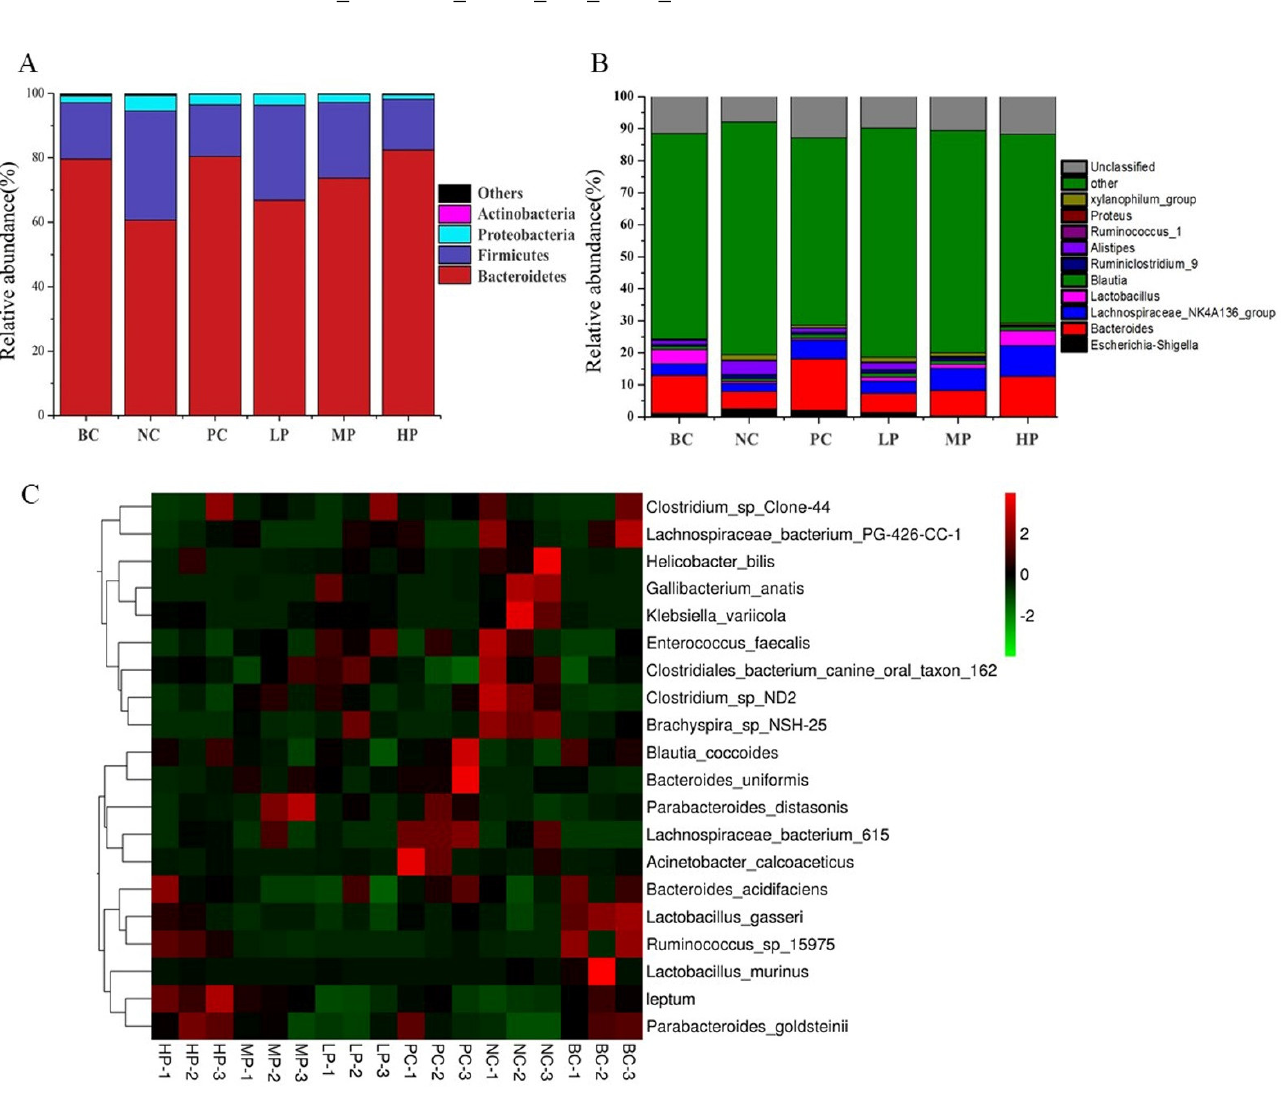
Figure 5. Composition of the gut microbiota represented by the stacking histograms at phylum level ( A ) and genus level ( B ), as well as a heatmap at species level ( C ). BC (blank control) represents healthy mice; NC (negative control) represents AAD mice without treatment; PC (positive control) represents AAD mice administrated with 200 mg/kg BW of inulin; LP, MP and HP represent AAD mice administrated with low-dosage (100 mg/kg BW), middle-dosage (200 mg/kg BW) and high-dosage (400 mg/kg BW) of BSP,